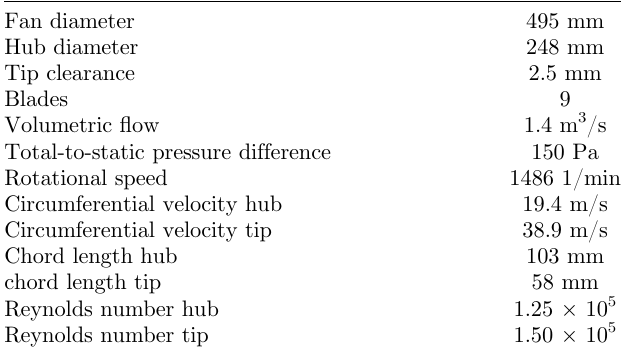
Table 1. Fan design parameters (according to [12]).